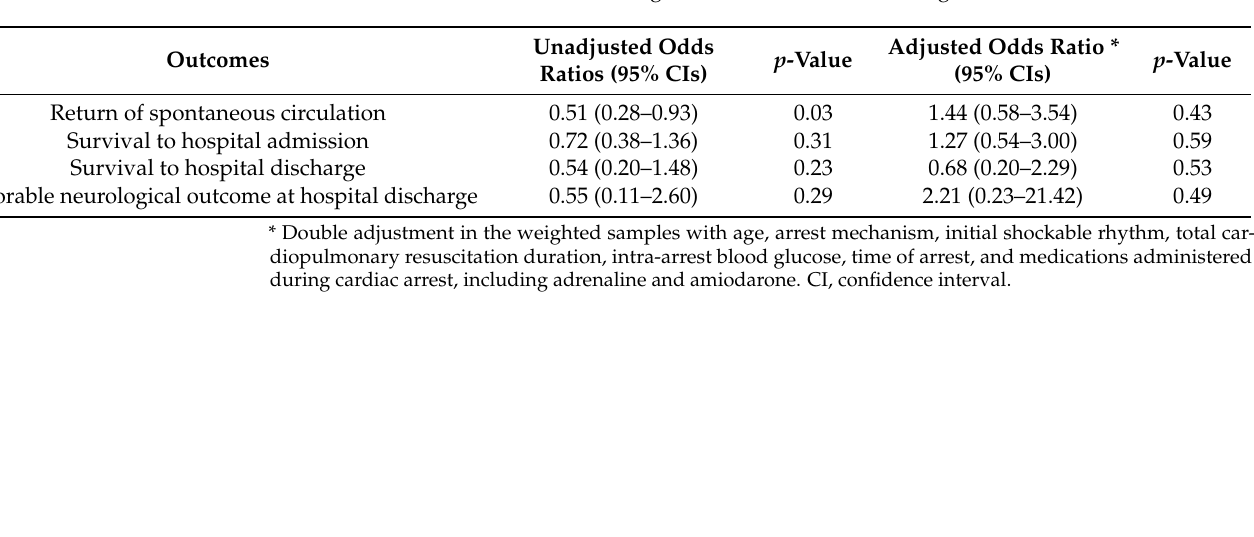
Table 2. Clinical outcomes for receiving intravenous dextrose during cardiac